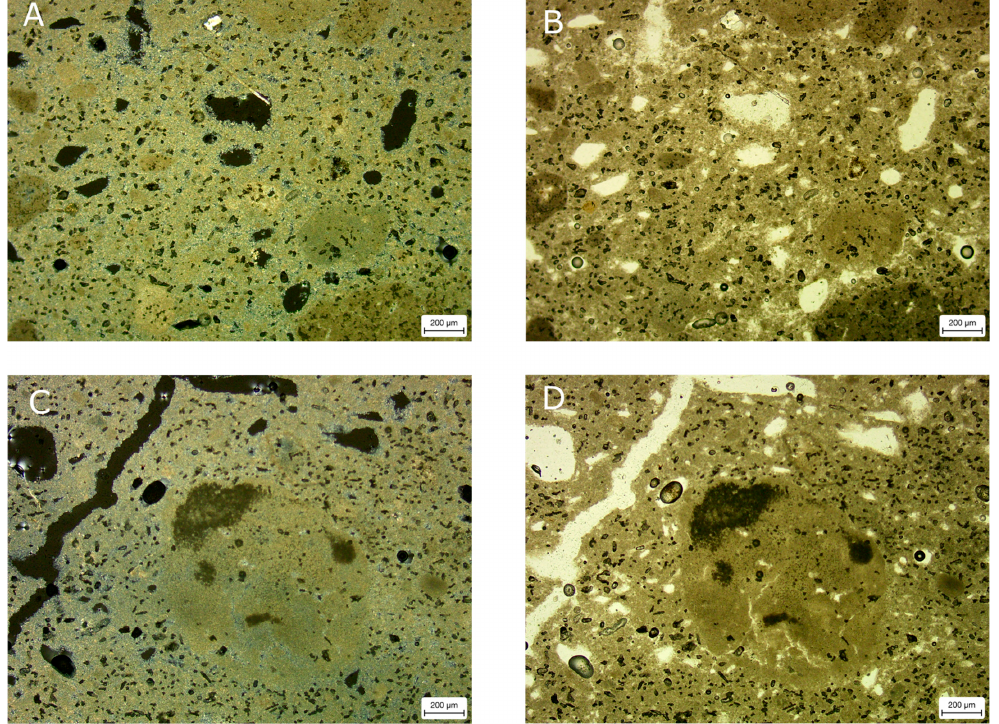
Figure 10. Photos ( A – D ) from sample NO2 with a low presence of aggregates. In photos ( C , D ), the lumps are clearly visible in the centre.